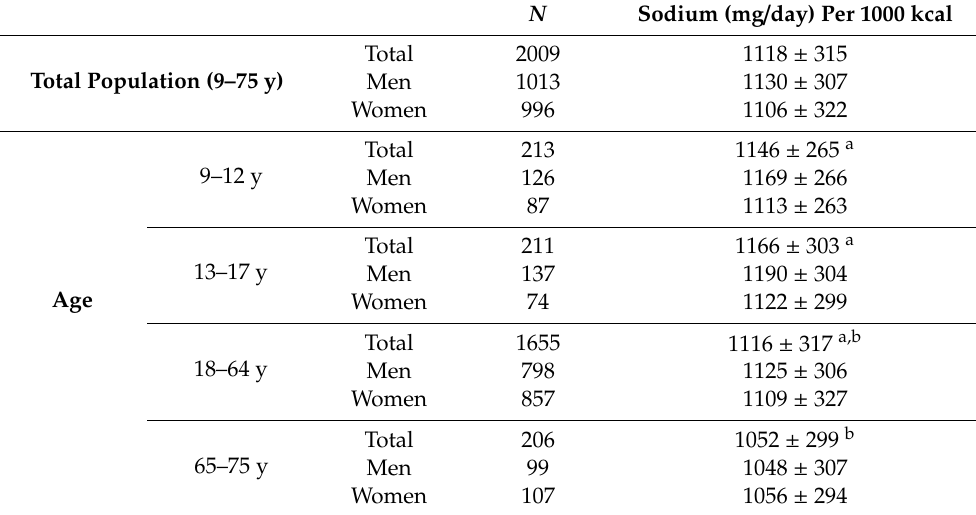
Table 2. Sodium intakes from foods per 1000 kcal consumed by the ANIBES study population (excluding added table and cooking